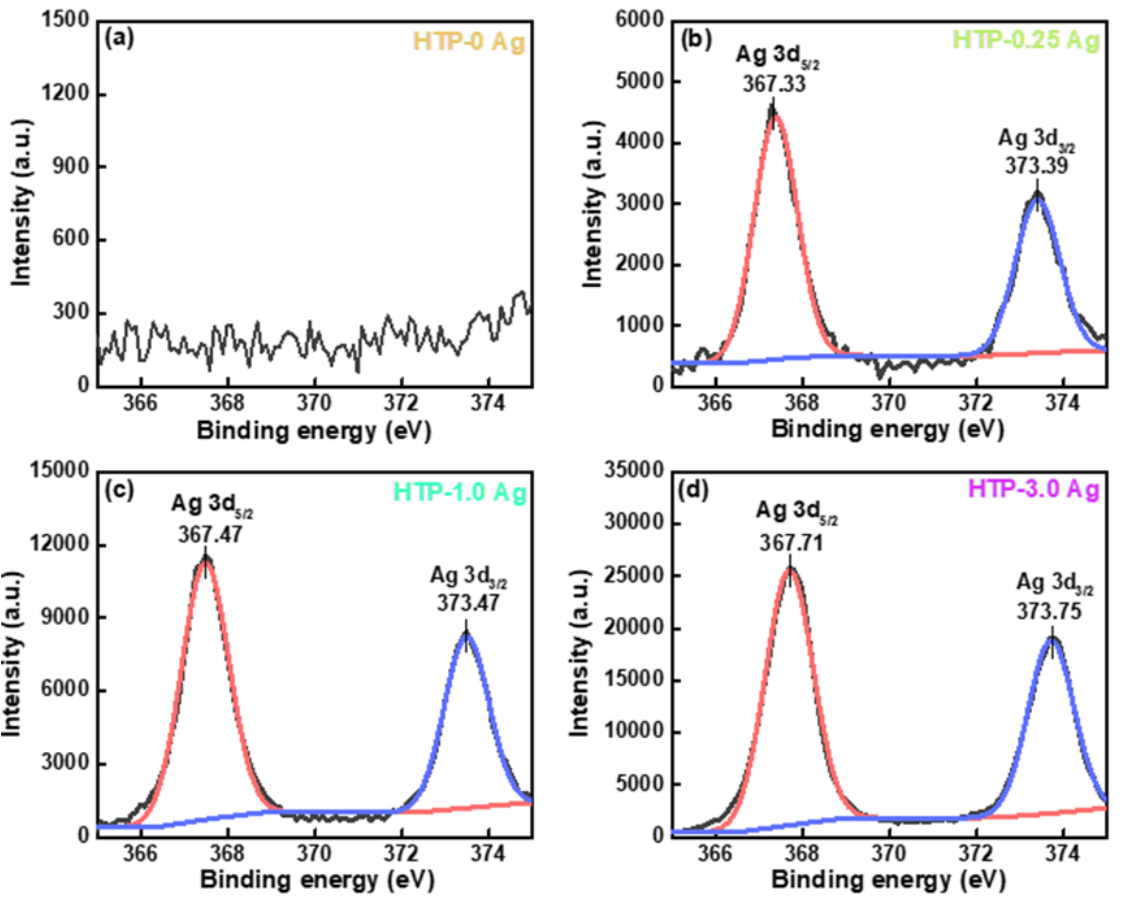
Figure 4. ( a – d ) Ag 3d XPS spectra of PG and CsPbBr 3 QD-doped glasses containing Ag NPs.